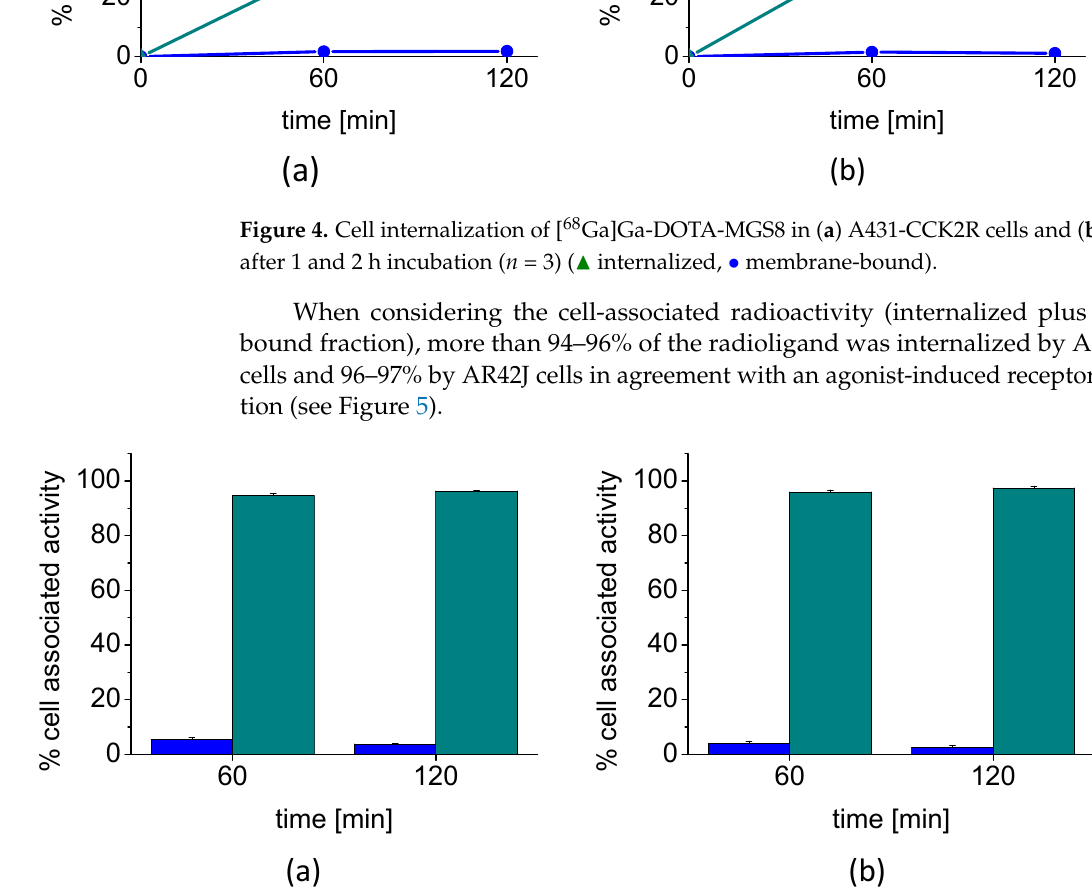
Figure 5. Distribution of the cell-associated radioactivity (internalized plus membrane-bound frac- tion) of [ 68 Ga]Ga-DOTA-MGS8 in ( a ) A431-CCK2R cells and ( b ) AR42J cells after 1 and 2 h incubation ( n = 3): membrane-bound (blue), internalized (cyan).